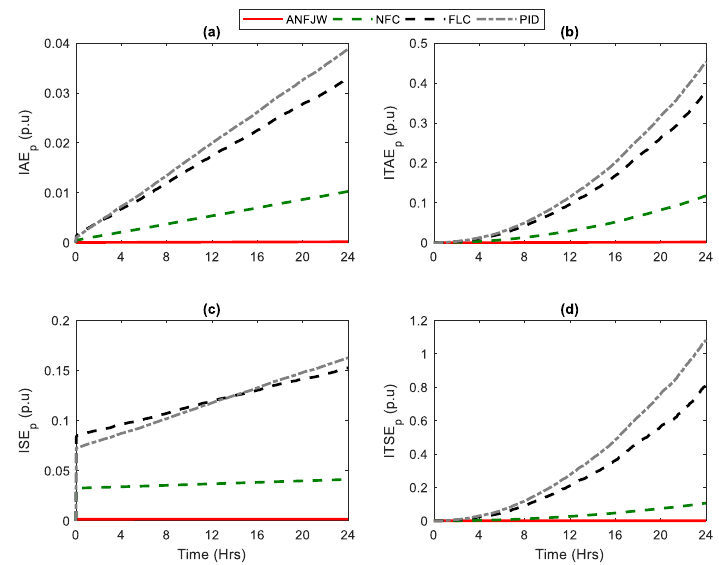
Figure 17. Power efficiency comparison of different controllers: ( a ) real power and ( b ) reactive power.